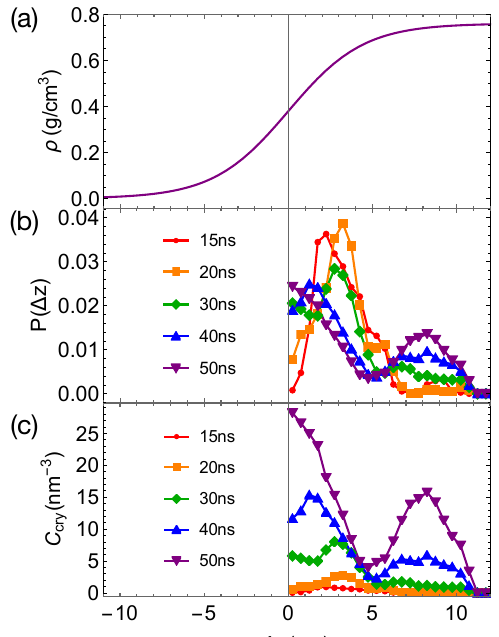
Figure 10. ( a ) Hyperbolic density profile of PE by fitting data in Figure 9a; ( b ) probability distribution of crystalline atoms vs. distance ∆ z from the closest planar interfaces at different simulation time; ( c ) concentration of crystalline atoms vs. ∆ z at different simulation times. Data in ( b , c ) are averaged over eight